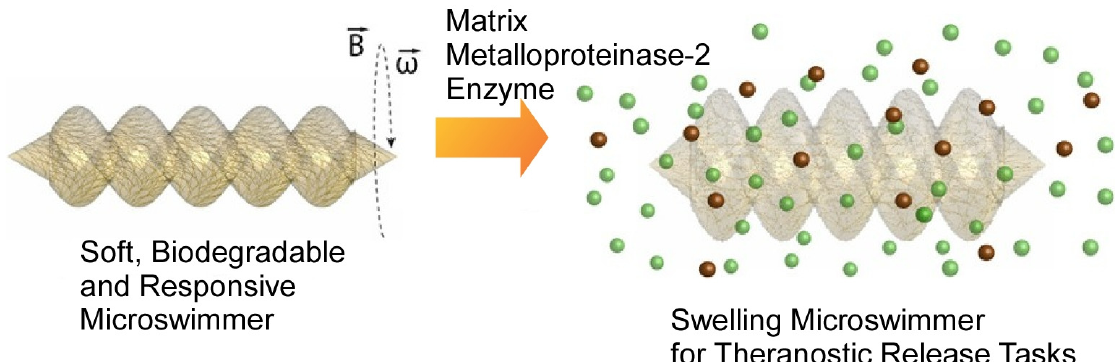
Figure 13. Hydrogel-based, hand-created, magnetically driven and controlled, enzymatically degradable miroswimmers with a swelling process for releasing the loaded drug molecules. Reproduced under terms of the CC-BY license [157].